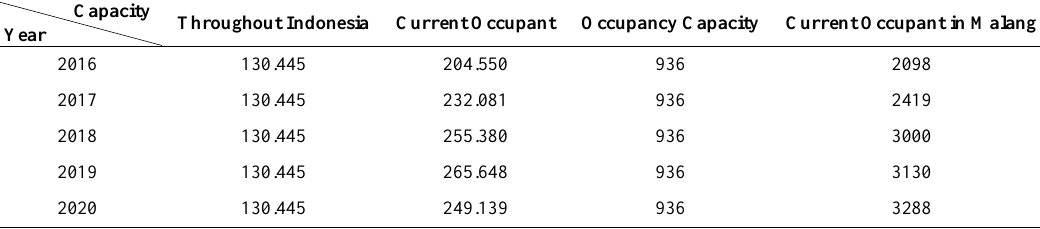
Table 1. Increasing Number of Resident in Malang Correctional Institution